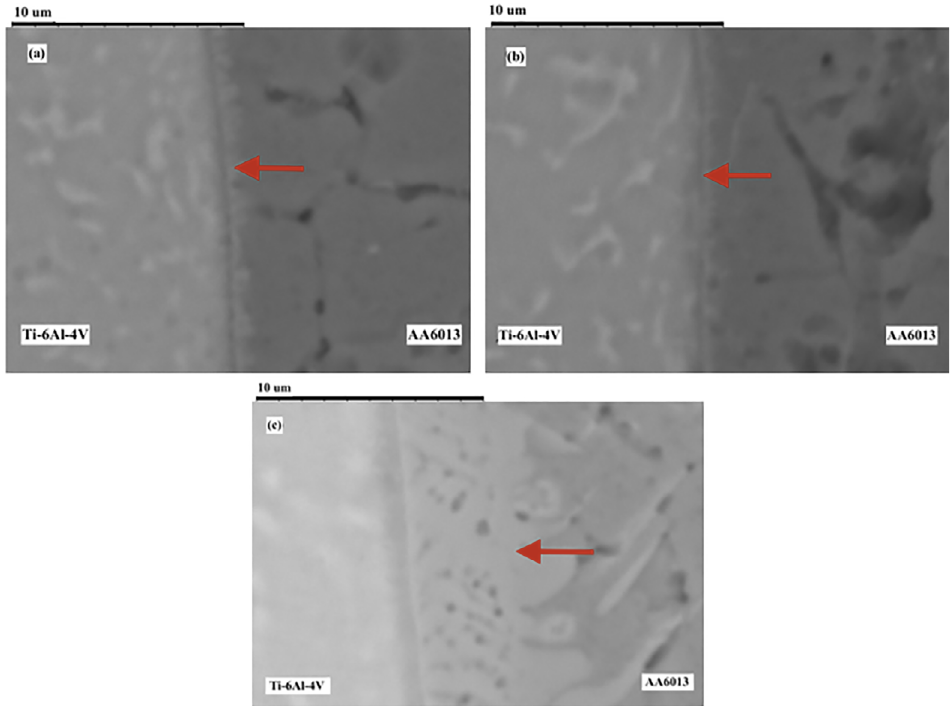
Figure 7. Effect of the silicon film deposited during (a) 1 hour and (b) 2 hours on Ti alloy, comparing with (c) a dissimilar joint without silicon